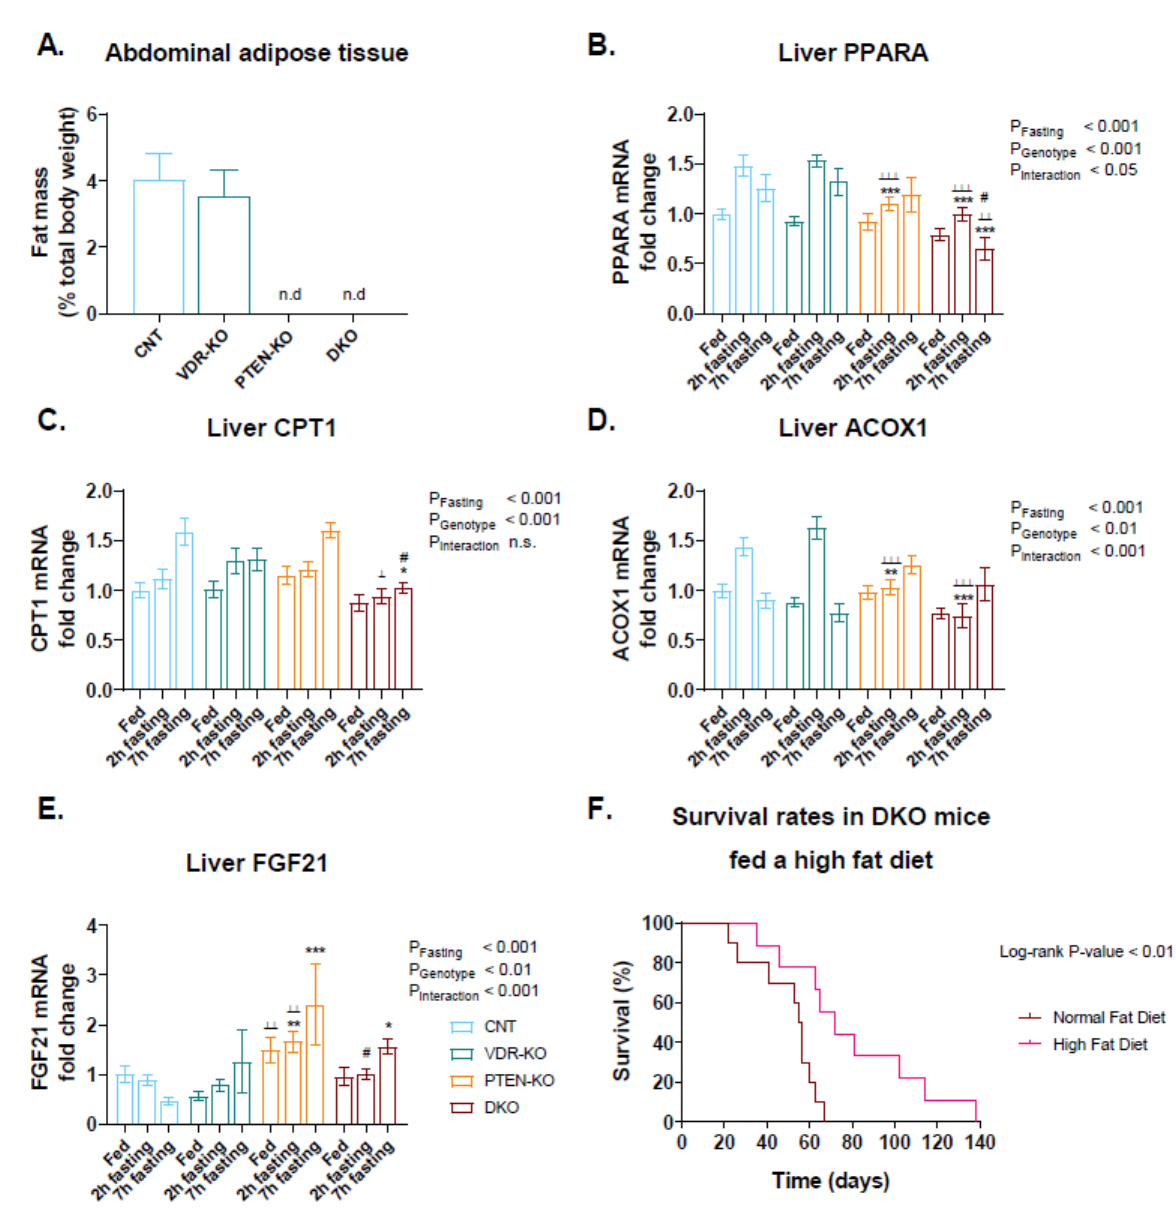
Figure 5. A high-fat diet extends lifespan in DKO mice. ( A ) Abdominal adipose tissue was absent in PTEN-KO and DKO mice. Liver mRNA expression of ( B ) Peroxisome proliferator-activated receptor alpha (PPARA), ( C ) Carnitine palmitoyltransferase I (CPT1), ( D ) Peroxisomal acyl-coenzyme A oxidase 1 (ACOX1) and ( E ) Fibroblast growth factor 21 (FGF21) using TATA-binding protein (TBP) as housekeeping gene. ( F ) Survival rates of DKO mice fed on a normal or high fat diet after cre-induced PTEN ablation. Log-rank p -value < 0.01. Data are represented as mean ± SEM. n.d: not detected. * p < 0.05 vs. CNT; ** p < 0.01 vs. CNT; *** p < 0.001 vs. CNT; ⊥ p < 0.05 vs. VDR-KO; ⊥⊥ p < 0.01 vs. VDR-KO; VDR-KO; ⊥⊥⊥ p < 0.001 vs. VDR-KO; # p < 0.05 vs. PTEN-KO. CNT: Control. VDR-KO: Vitamin D receptor knockout. PTEN-KO: Phosphatase and tensin homolog knockout. DKO: Double knockout.